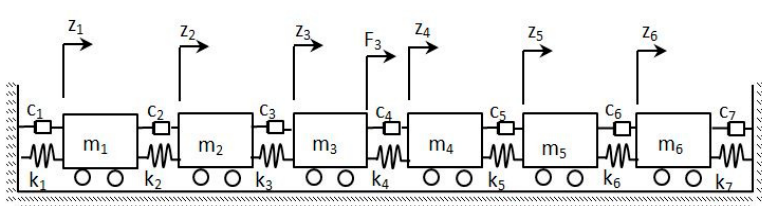
Figure 3. The lamped mass model of the numerical case study.